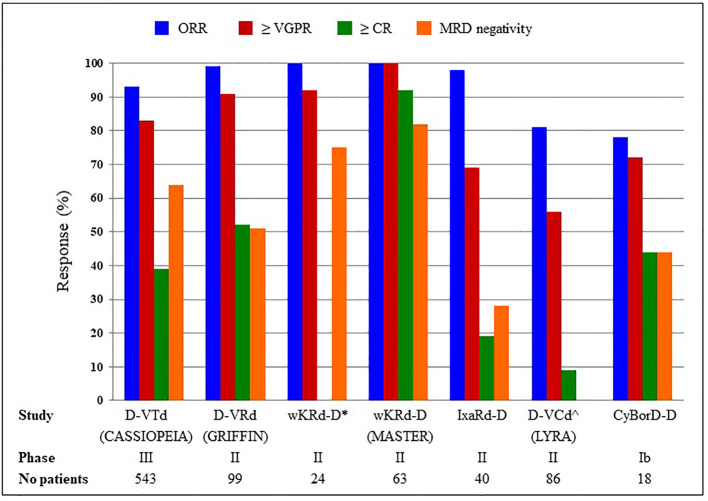
D-VTd, daratumumab, bortezomib, thalidomide, dexamethasone; D-VRd, daratumumab, bortezomib, lenelidomide, dexamethasone; wKRd_D, weekly carfilzomib, lenalidomide, dexamethasone, daratumumab; IxaRd-D, ixazomib, lenalidomide, dexamethasone, daratumumab; D-VCd and CyBorD-D, daratumumab, cyclophosphamide, bortezomib, dexamethasone. *≥ CR not available; ^MRD status not available.